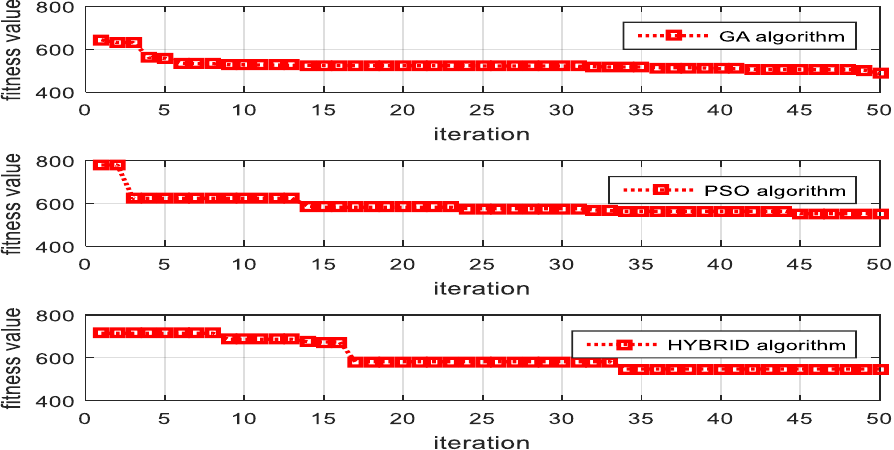
Figure 10. Fitness value for GA, PSO, and hybrid-based optimization technique using PEM for scenario-3.